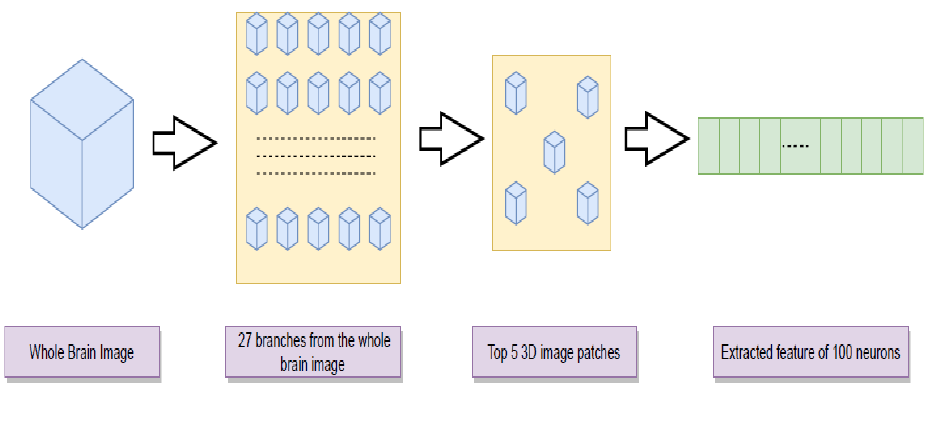
Figure 3. Pipeline of feature extraction using a multi-branch CNN